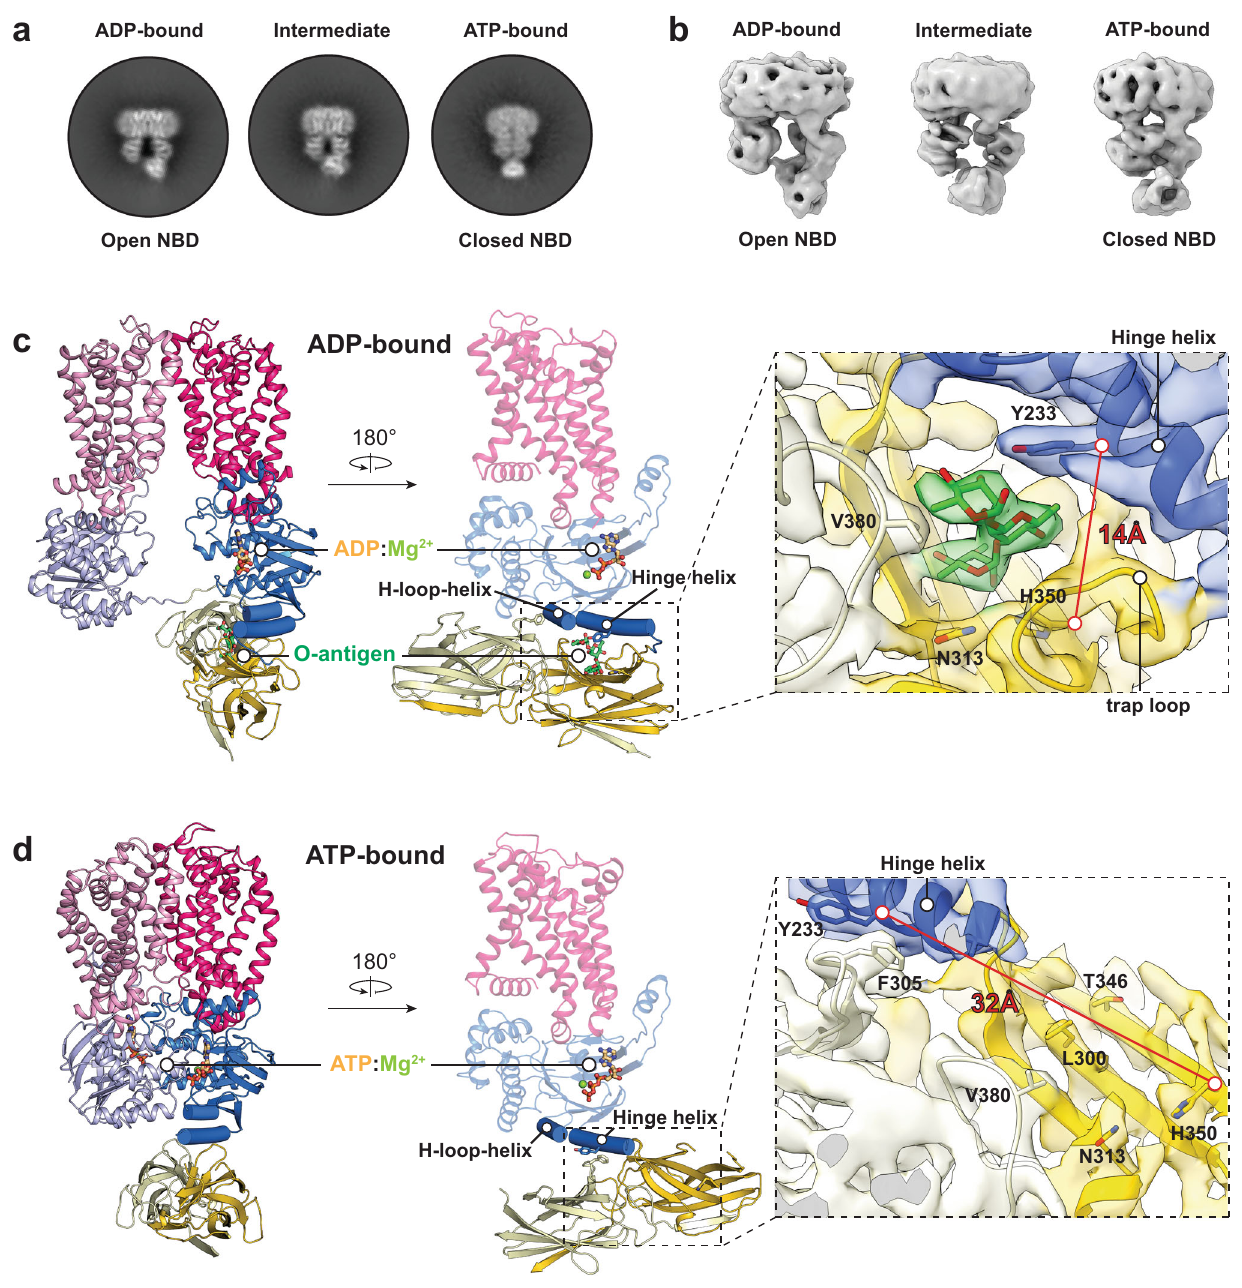
Fig.5|ATPbindingdisplacestheOantigenfromtheCBD.a , b Representative2D and 3DclassesofWzmWzt conformationalstatesidenti fi ed during ATPhydrolysis. c Cartoon model of WzmWzt bound to ADP:Mg 2+ and O antigen. Domains are colored as shown in Fig. 3. The O antigen density is colored green. O antigen and ADParepresentedassticksandMg 2+ asalimesphere.Zoomwindow:Localmapof